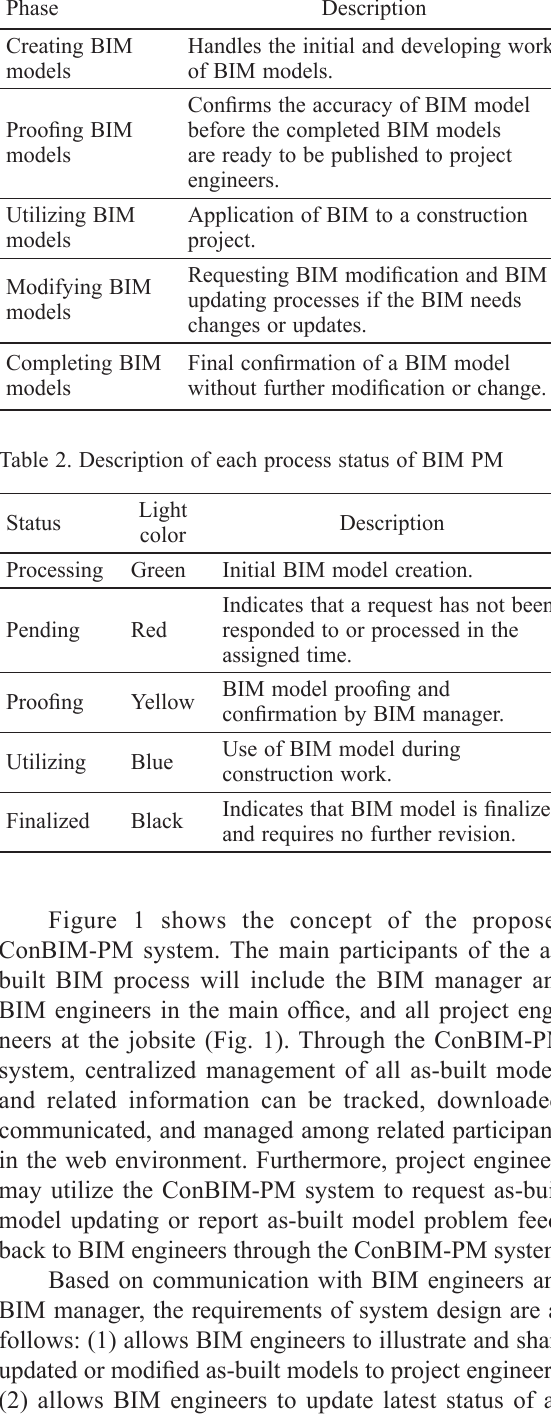
Table 1. Description of each BIM PM phase during the construction phase Phase